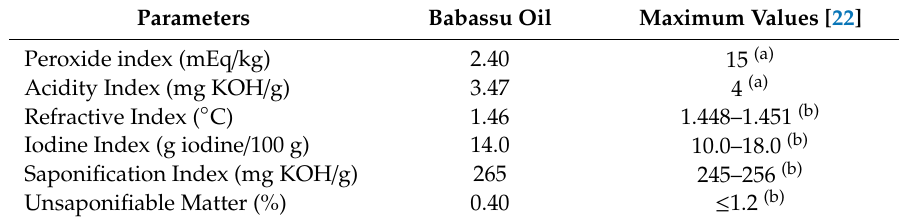
Table 2. Physicochemical aspects of babassu oil compared to quality parameters from Codex